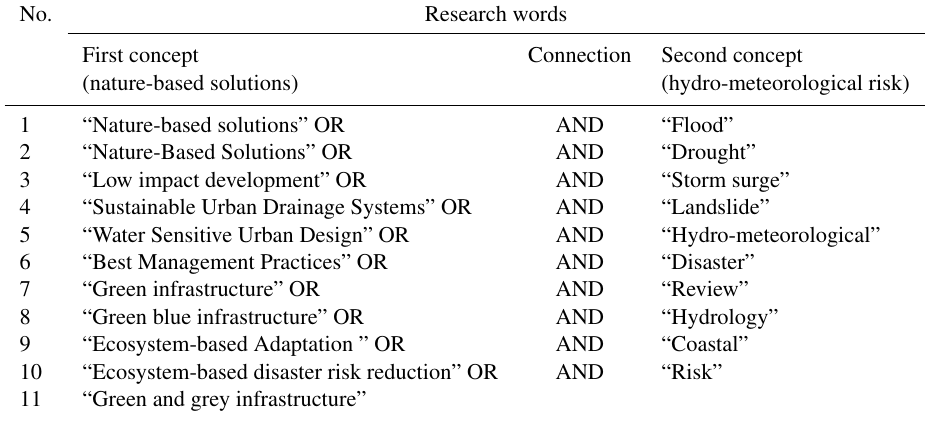
Table 2. Selected concepts and terms used to search relevant literature on NBSs for hydro-meteorological risk reduction. No. Research words First concept Connection Second concept (nature-based solutions) (hydro-meteorological risk) 1 “Nature-based solutions” OR AND “Flood” 2 “Nature-Based Solutions” OR AND “Drought” 3 “Low impact development” OR AND “Storm surge” 4 “Sustainable Urban Drainage Systems” OR AND “Landslide” 5 “Water Sensitive Urban Design” OR AND “Hydro-meteorological” 6 “Best Management Practices” OR AND “Disaster” 7 “Green infrastructure” OR AND “Review” 8 “Green blue infrastructure” OR AND “Hydrology” 9 “Ecosystem-based Adaptation ” OR AND “Coastal” 10 “Ecosystem-based disaster risk reduction” OR AND “Risk” 11 “Green and grey